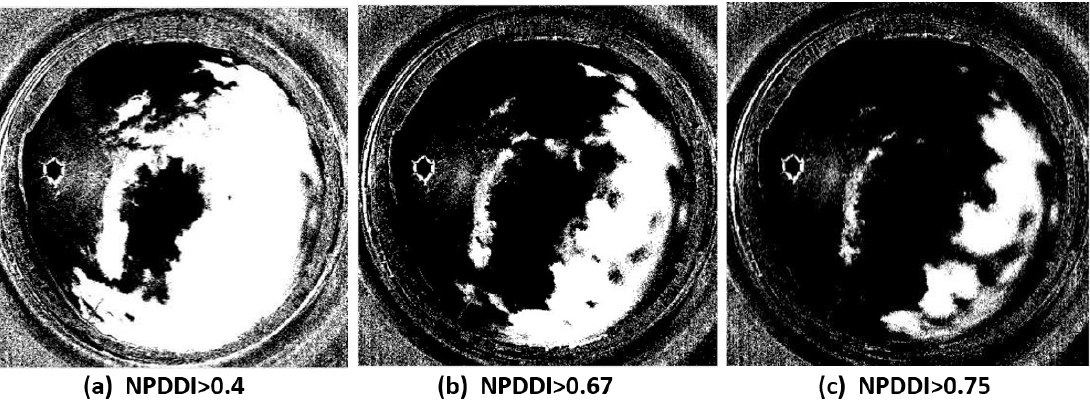
Figure 11. Cloud segmentation results when the NPDDI is larger than 0.4, 0.67, and 0.75, respec ‐ tively. To show the segmentation effect of different NPDDI values more clearly, the results are trans ‐ formed into binary